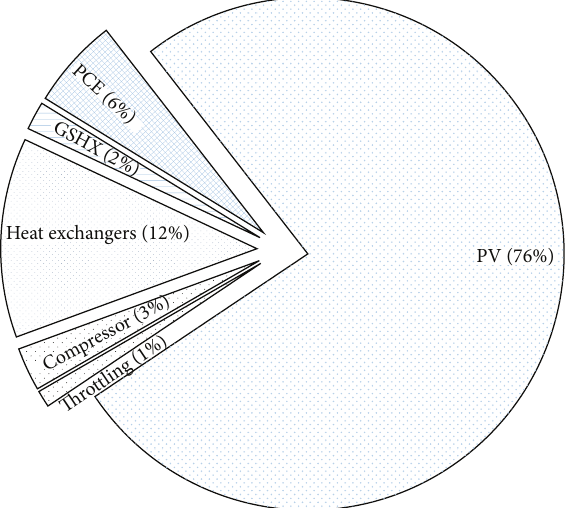
Figure 9: Relative irreversibility of components.